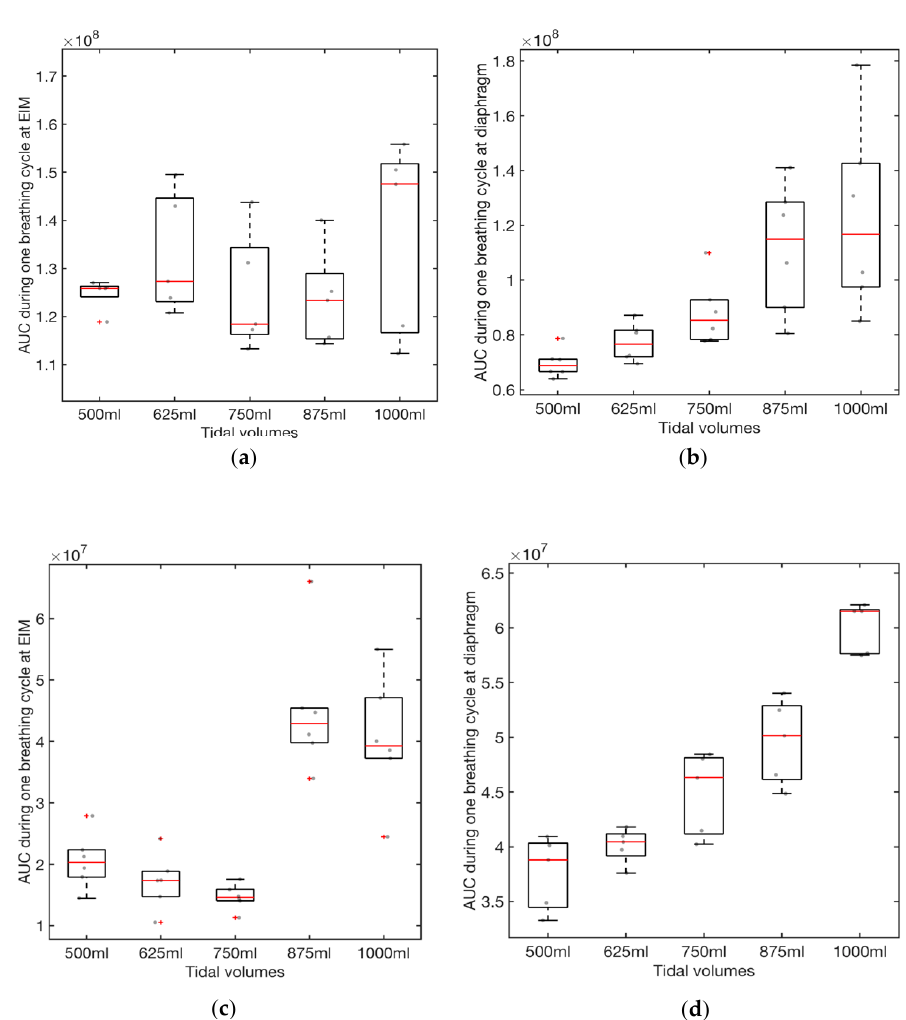
Figure 6 . Box plots for the AUCs during one breathing cycle for different tidal volumes: ( a ) Sensor is placed at the EIM (subject 1, male); ( b ) Sensor is placed at the diaphragm (subject 1) ; ( c ) Sensor is placed at the EIM (subject 2, female); (d ) Sensor is placed at the diaphragm (subject 2).